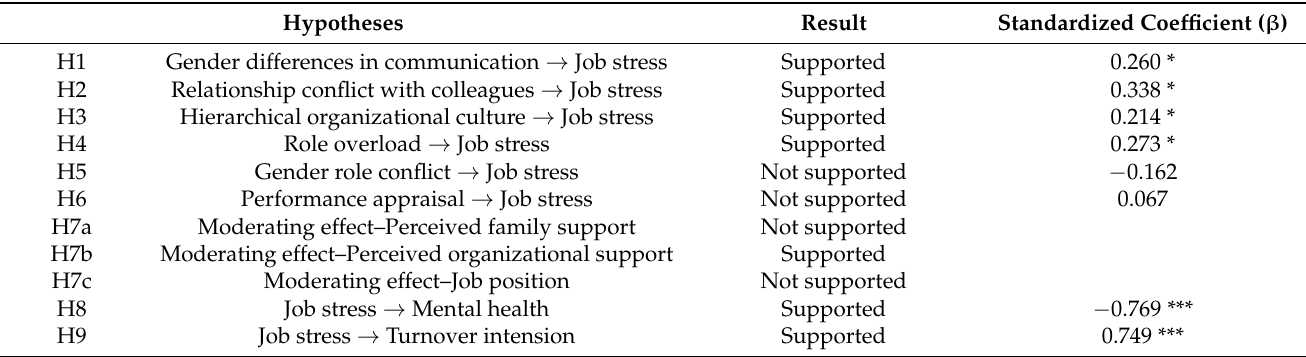
Table 11. Summary of hypotheses verification